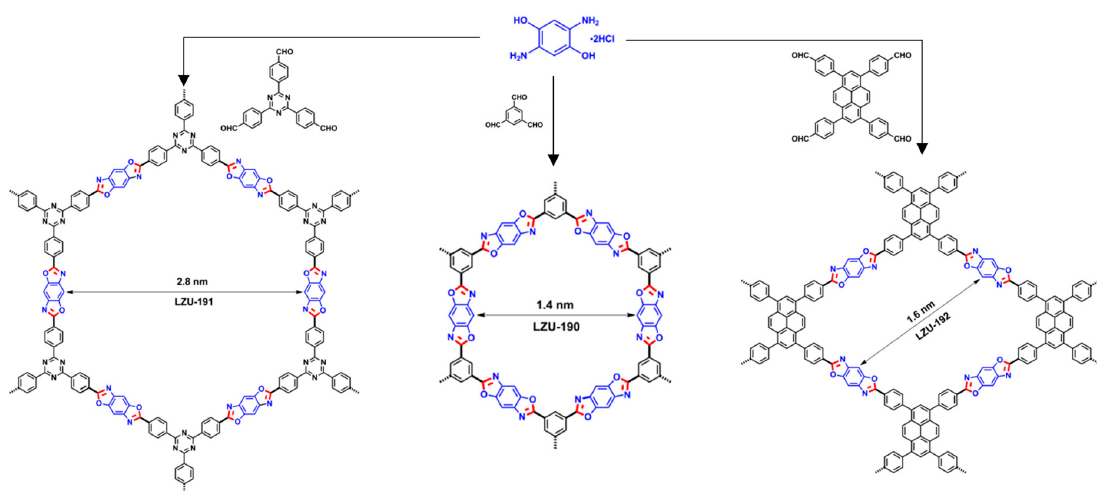
Figure 13. Design of benzoxazole ‐ linked COFs. Adapted with permission from Reference [66], Copyright (2019) American Chemical Society.